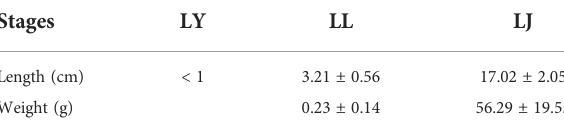
TABLE 1 Length and weight of Larimichthys crocea at different developmental stages: yolk-sac larvae (LY), larvae (LL), and juveniles